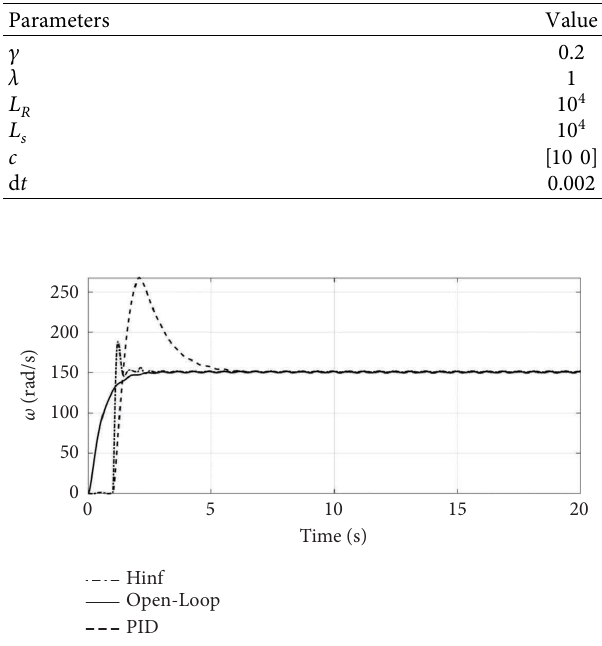
Figure 8: Te angular velocity of the second-order system for τ � 1s and sinusoidal disturbance.